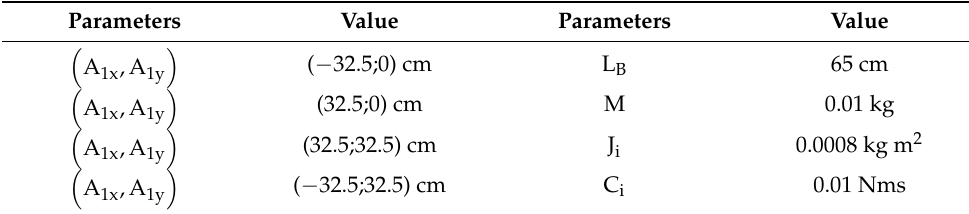
Table 3. Main values of parameters for the proposed case study.